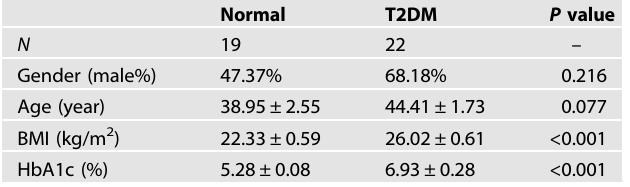
Table 1. Characteristics of subjects in different